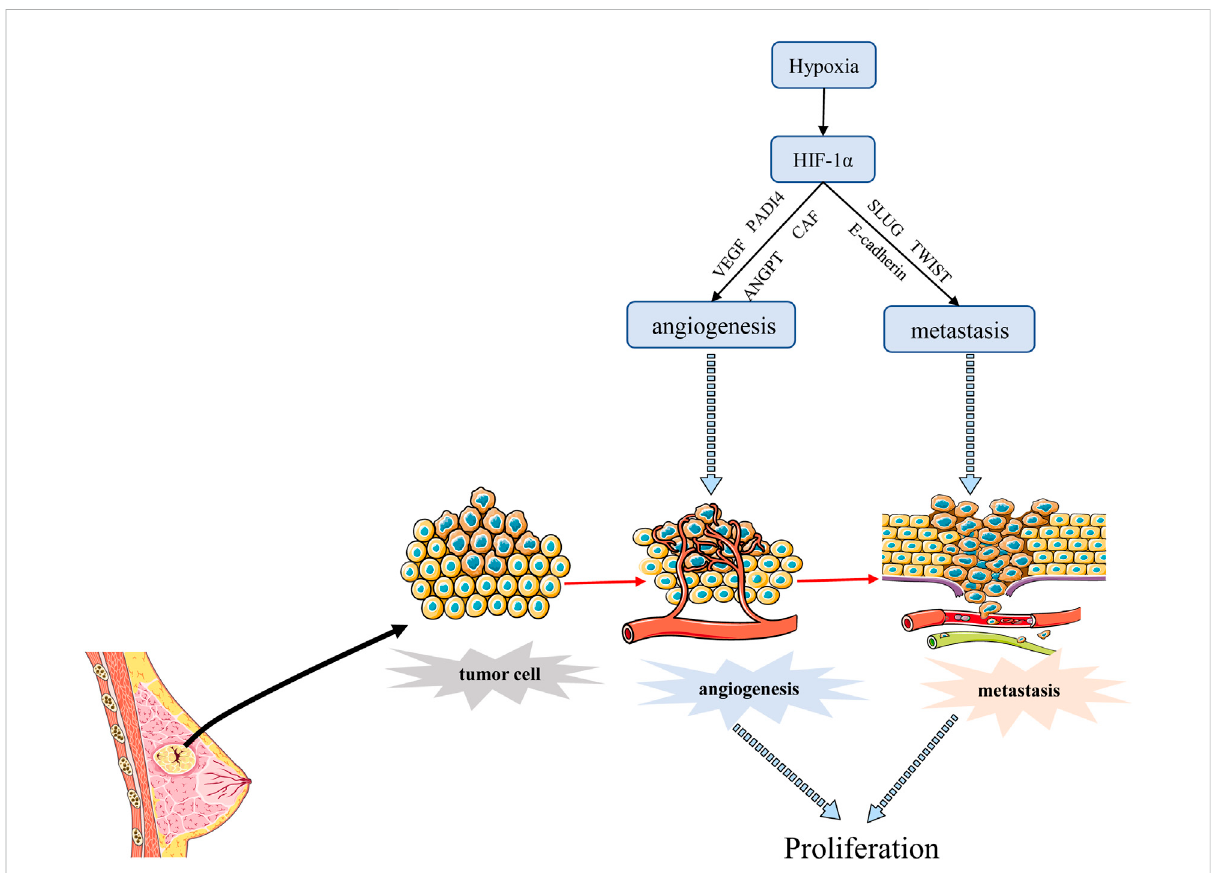
FIGURE 4 HIF-1 α regulatestheangiogenesisandmetastasisofBC.HIF-1 α promotesangiogenesismainlybystimulatingVEGFtranscription,andpromotes BC metastasis through EMT process. Angiogenesis can also promote transfer to normal